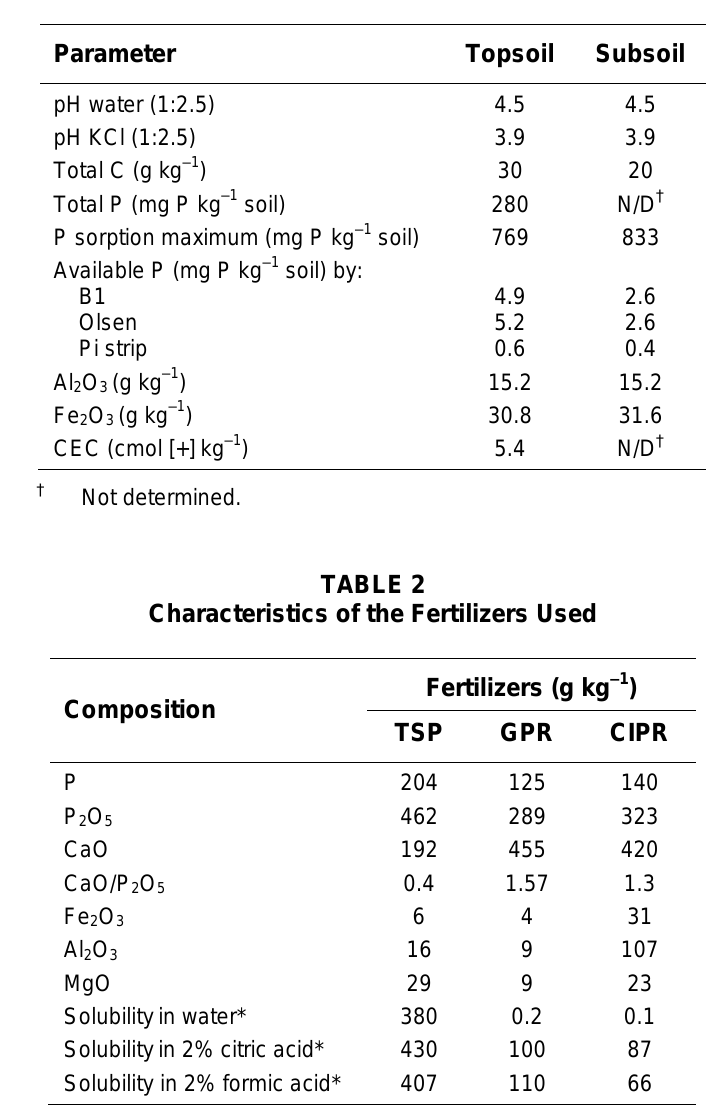
Characteristics of the Top- and Subsoil